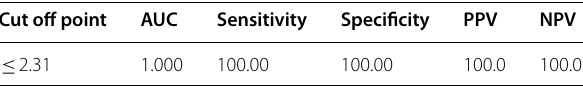
Table 11 ROC curve for adiponectin level as a predictor for liver fibrosis Cut off point